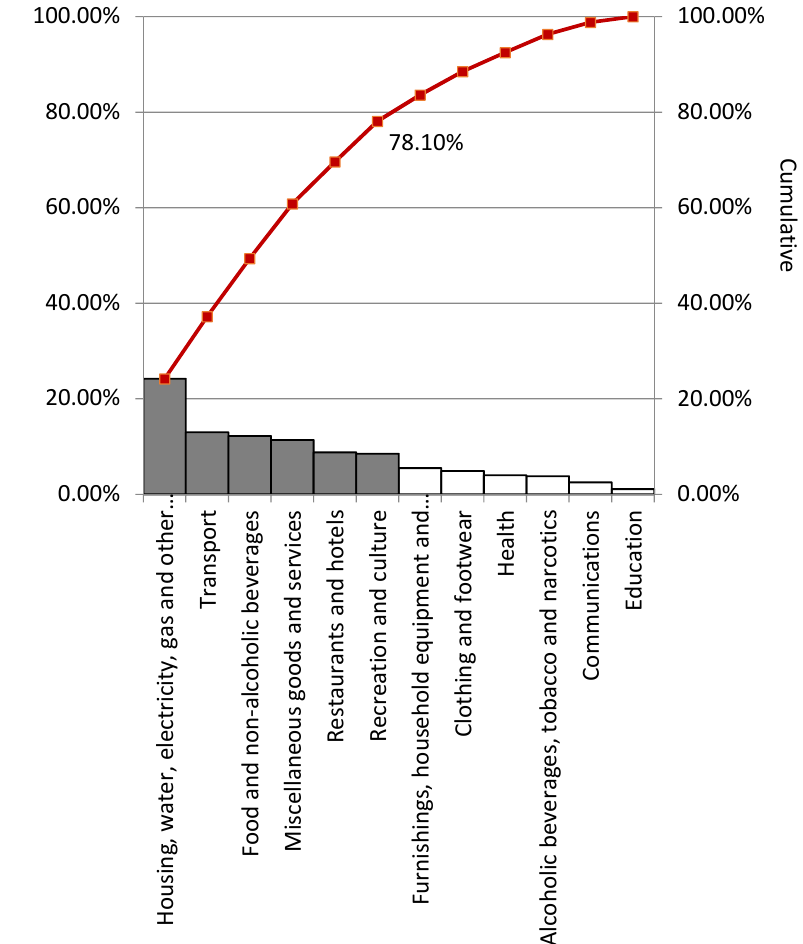
Figure 1. Structure of household expenditure in the countries of the EU in 2017. Source: created by authors according to data from [61].